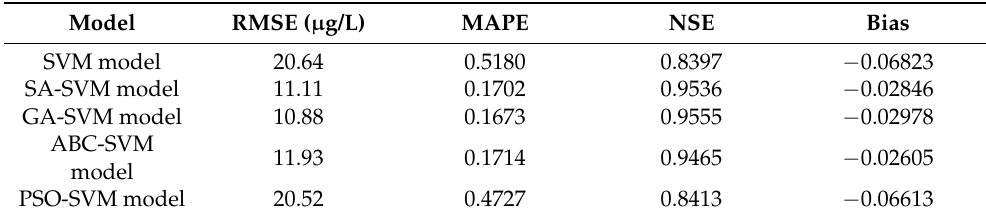
Table 4. The modeling error comparison of each